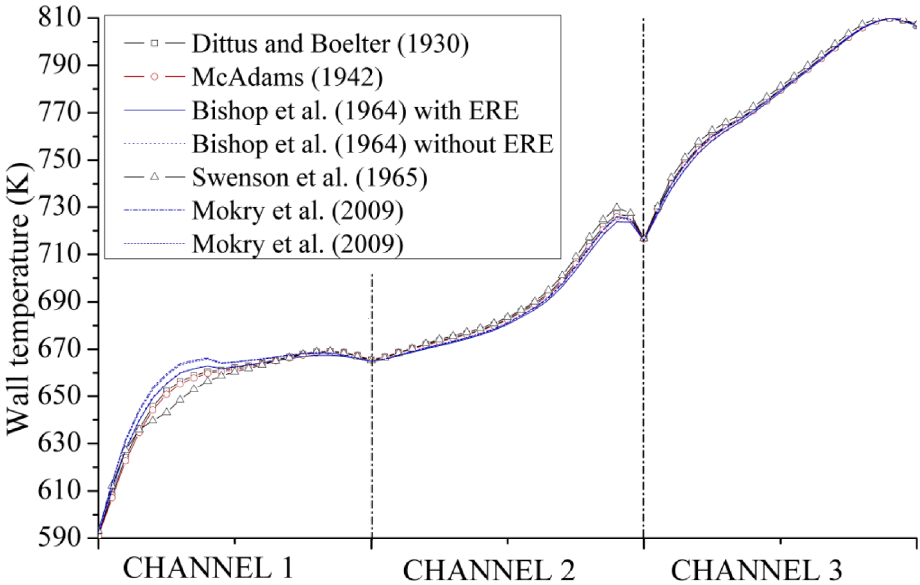
Fig. 11. Simulation results showing the wall temperature behavior across the three channels for different